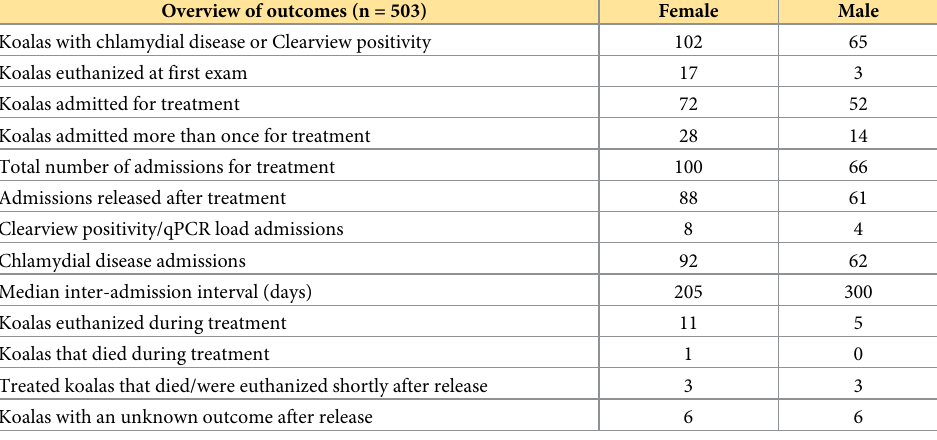
Table 1. Summary of clinical outcomes for koalas with chlamydial disease or Chlamydia antigen positivity only during the koala management program. Overview of outcomes (n = 503)